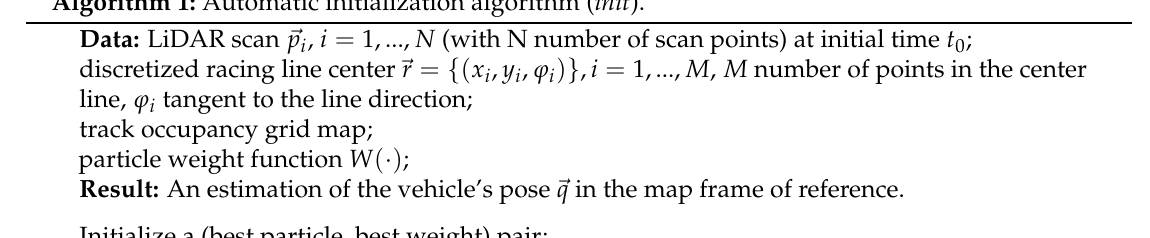
Algorithm 1: Automatic initialization algorithm ( init ).